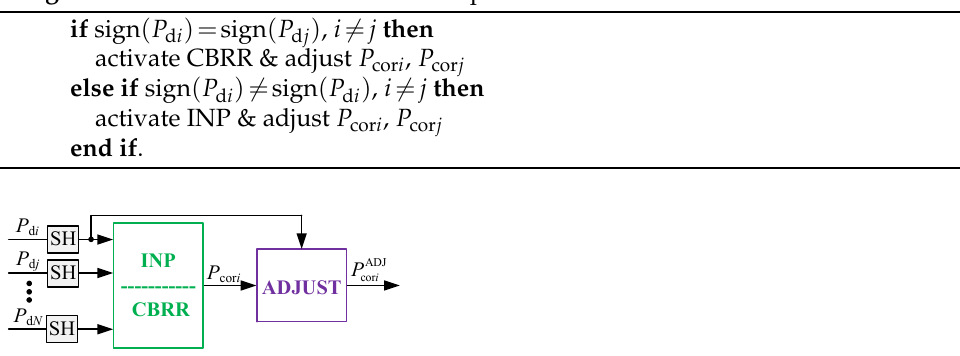
Algorithm 1: The code of simultaneous operation of the INP and the CBRR.